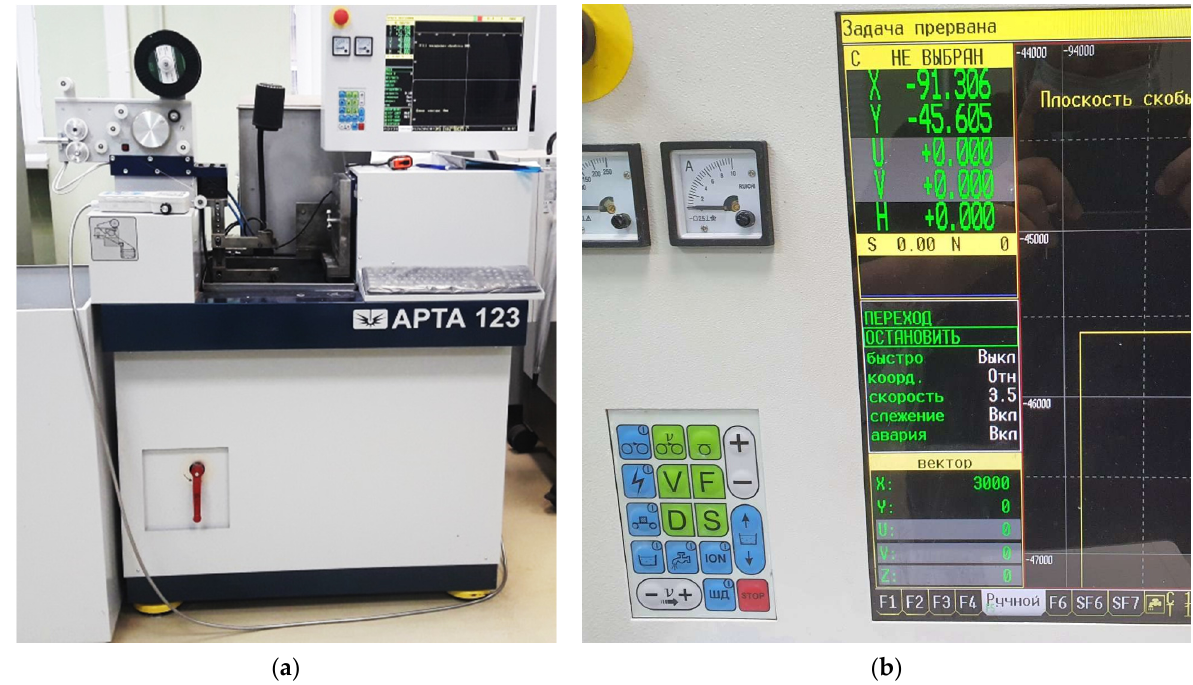
Figure 2. Electrical discharge machine ARTA 123 Pro: ( a ) general view; ( b ) a view of the working panel after machining. Table 2. Electrical discharge machining factors (ARTA 123 Pro machine)